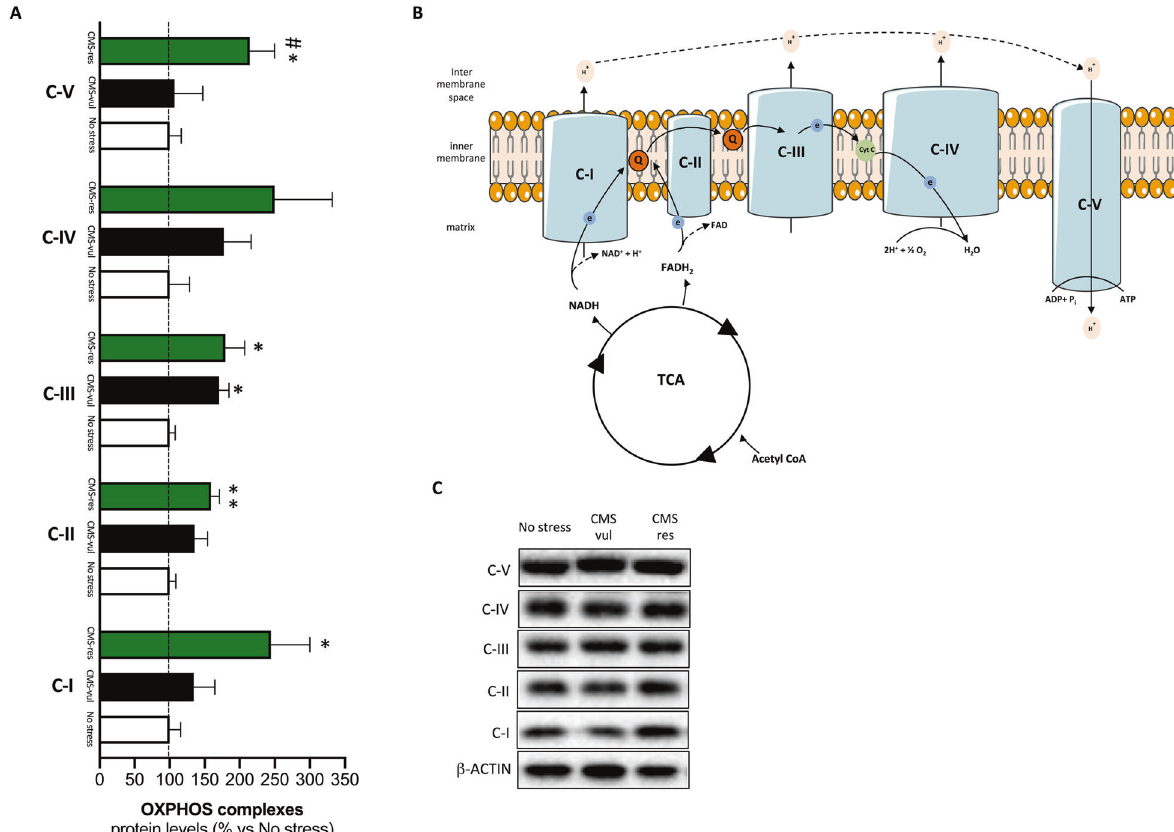
Fig. 4 Analysis of OXPHOS complexes in the vHip of vulnerable and resilient animals to CMS. A OXPHOS complexes protein levels. The data are the mean ± SEM; B schematic representation of the electron transport chain; C representative WB blots. * P < 0.05, ** p < 0.01 vs no stress, # p < 0.05 vs CMS-vul (one-way ANOVA with Fisher ’ s